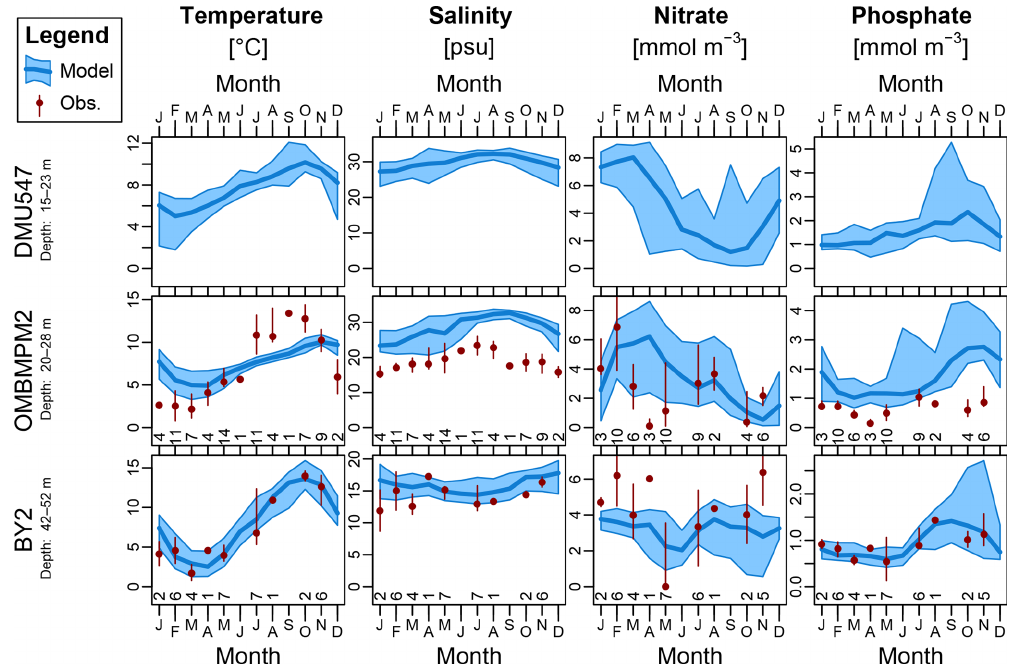
Figure 6. Similar to Fig. 5 but for the bottom 8 to 10m. The exact depth range is given on the left. A similar figure showing data at the other three stations is provided in the Supplement.